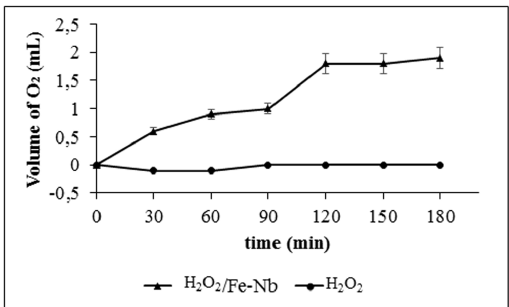
as a function of the 2